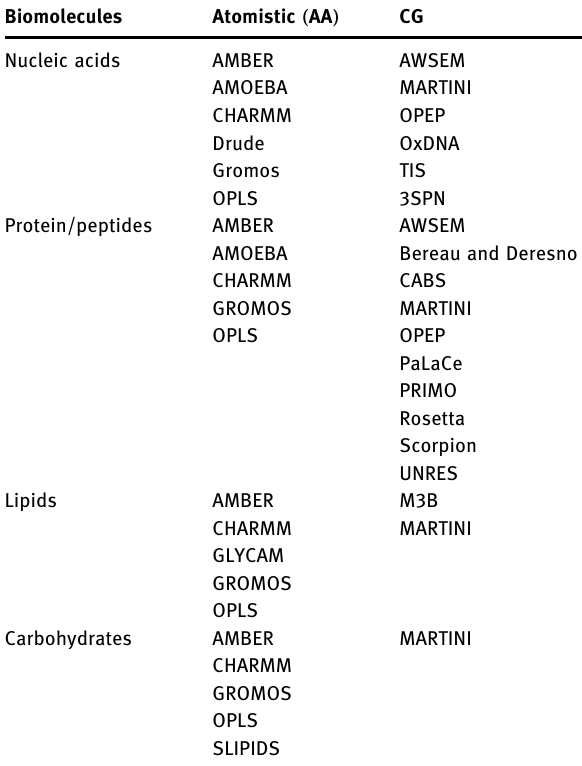
Table 1: Biomolecules vs force fi elds